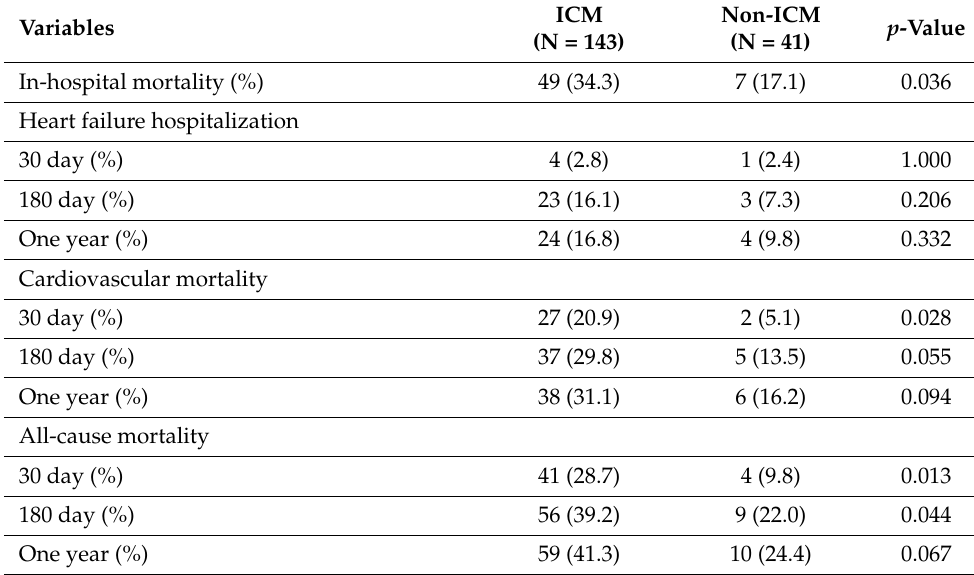
Table 3. In-hospital and one-year outcomes.